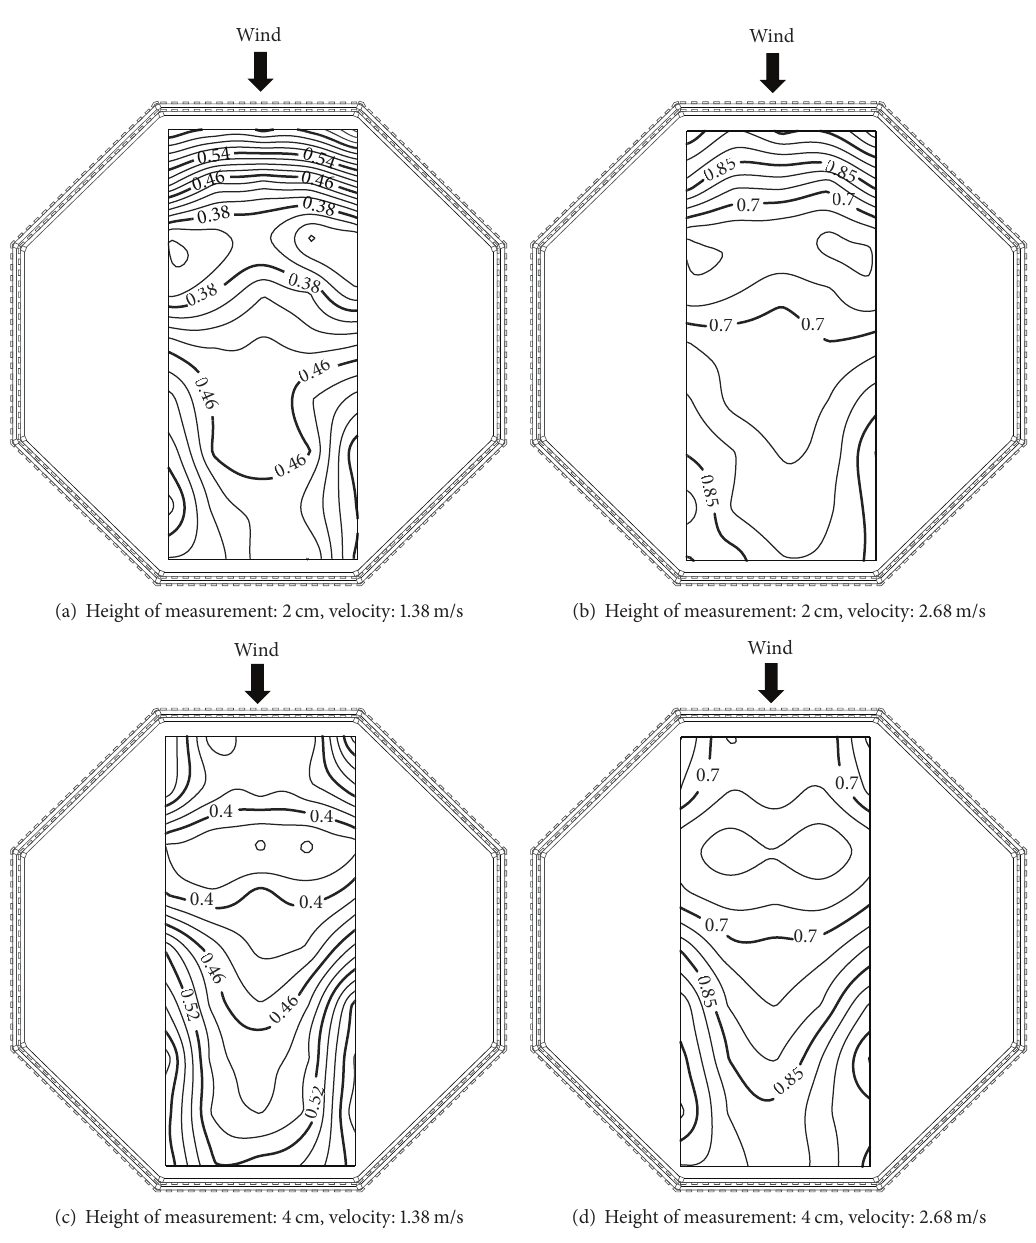
Figure 18: Distribution of wind velocity within the windbreak (CASE